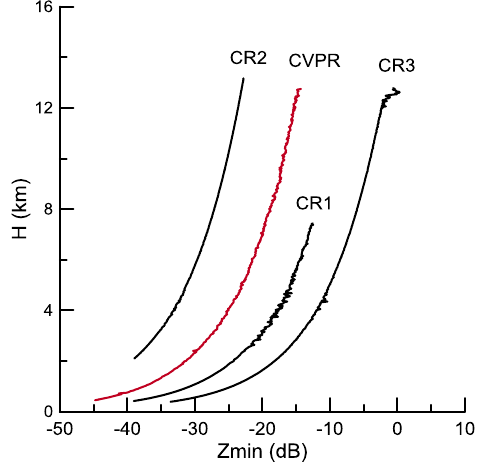
Figure 1. Changes in minimum detectable reflectivity as a function of height for CR’s modes (black) and CVPR (red).